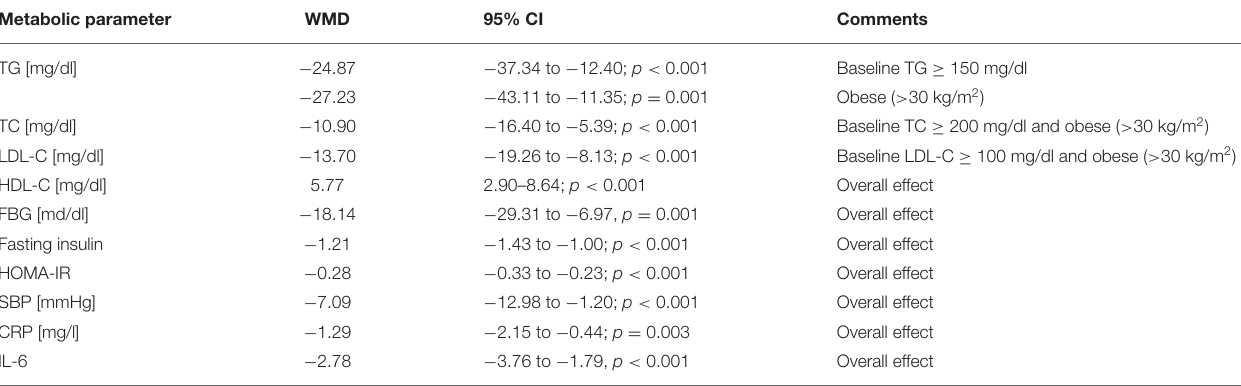
TABLE 4 | The effect of nano-curcumin supplementation on the control of cardiovascular parameters. Based on (140). Metabolic parameter